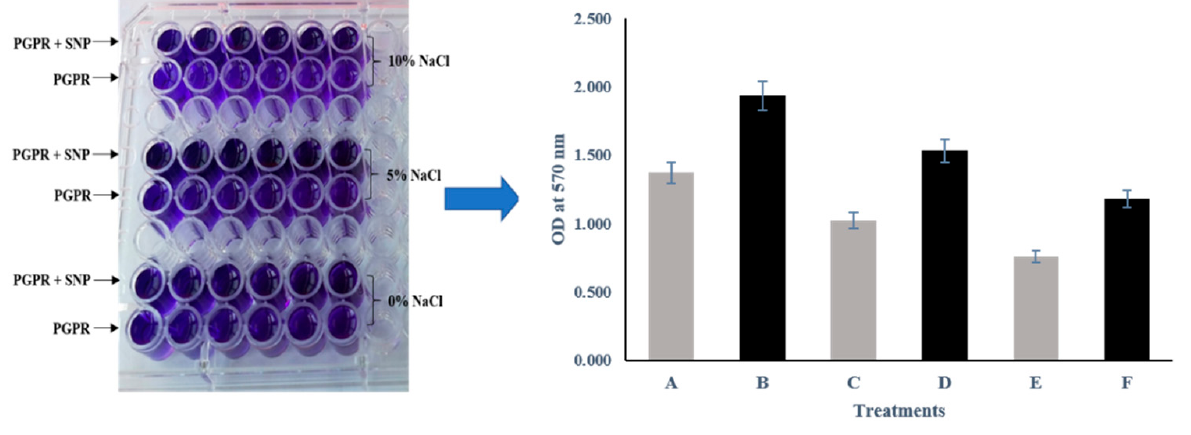
Figure 4. Effect of SNP (100 µ M) amendment on PGPR biofilm formation under 5% and 10% NaCl stress. A: PGPR; B: PGPR + SNP; C: PGPR + 5% NaCl; D: PGPR + SNP + 5% NaCl; E: PGPR + 10% NaCl; F: PGPR + SNP + 10% NaCl.